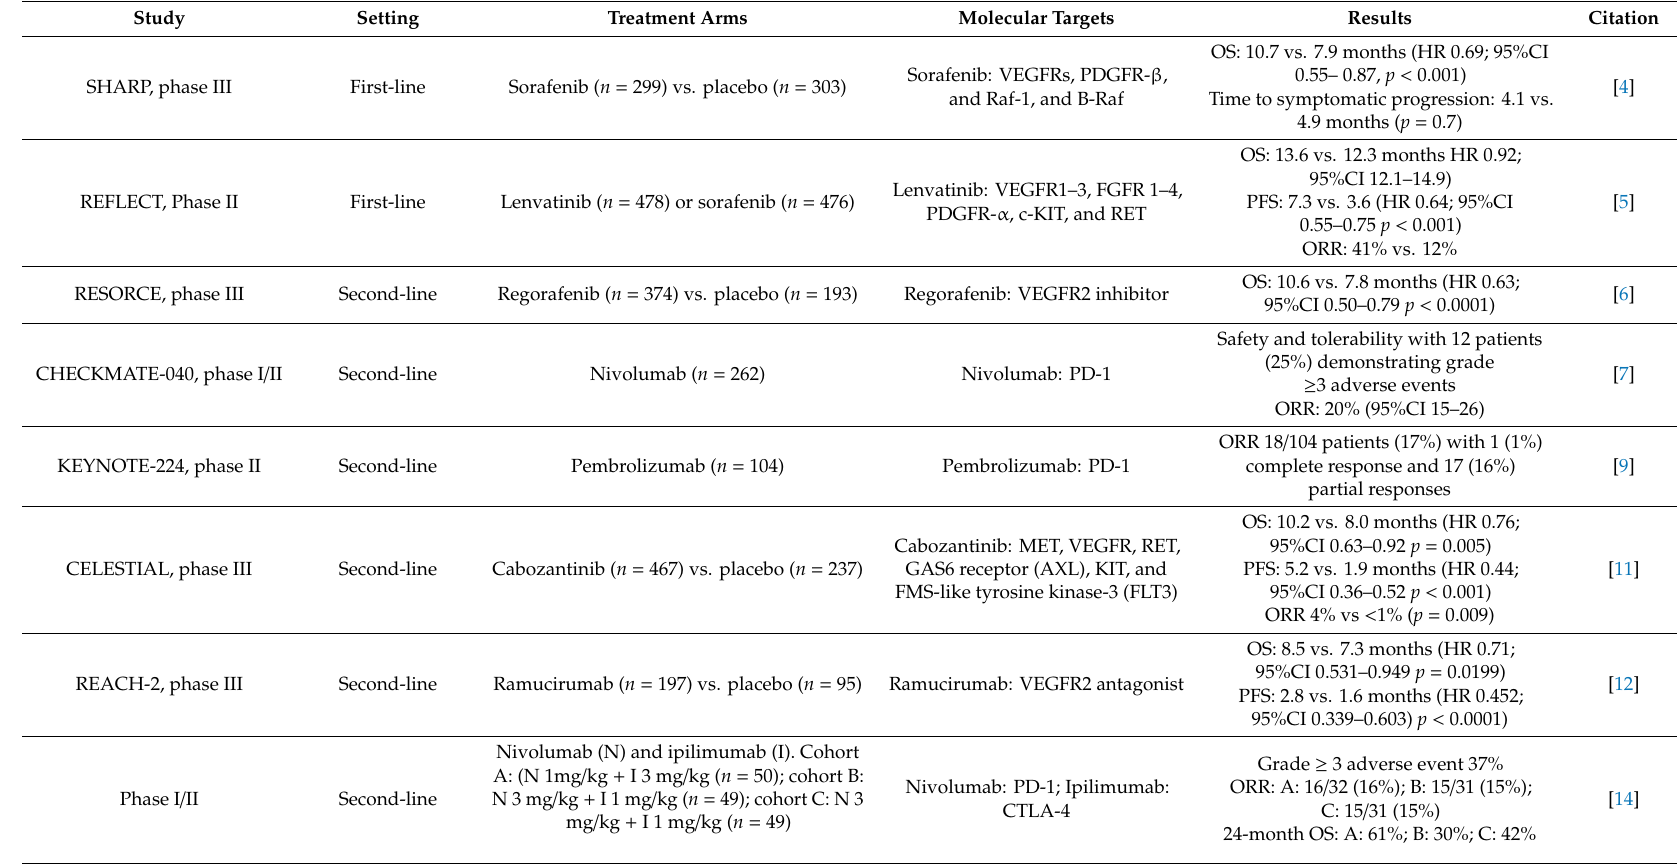
Table 1. Approved systemic therapies in advanced hepatocellular